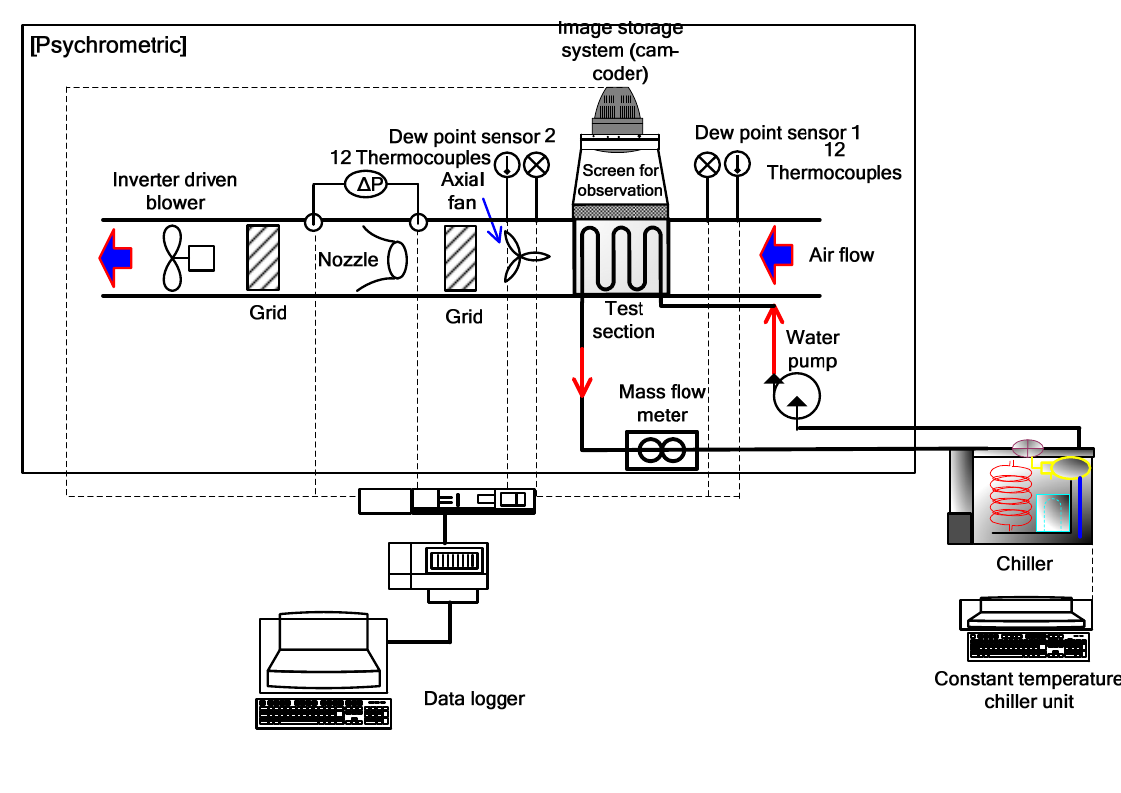
Figure 1. Schematic diagram of the test